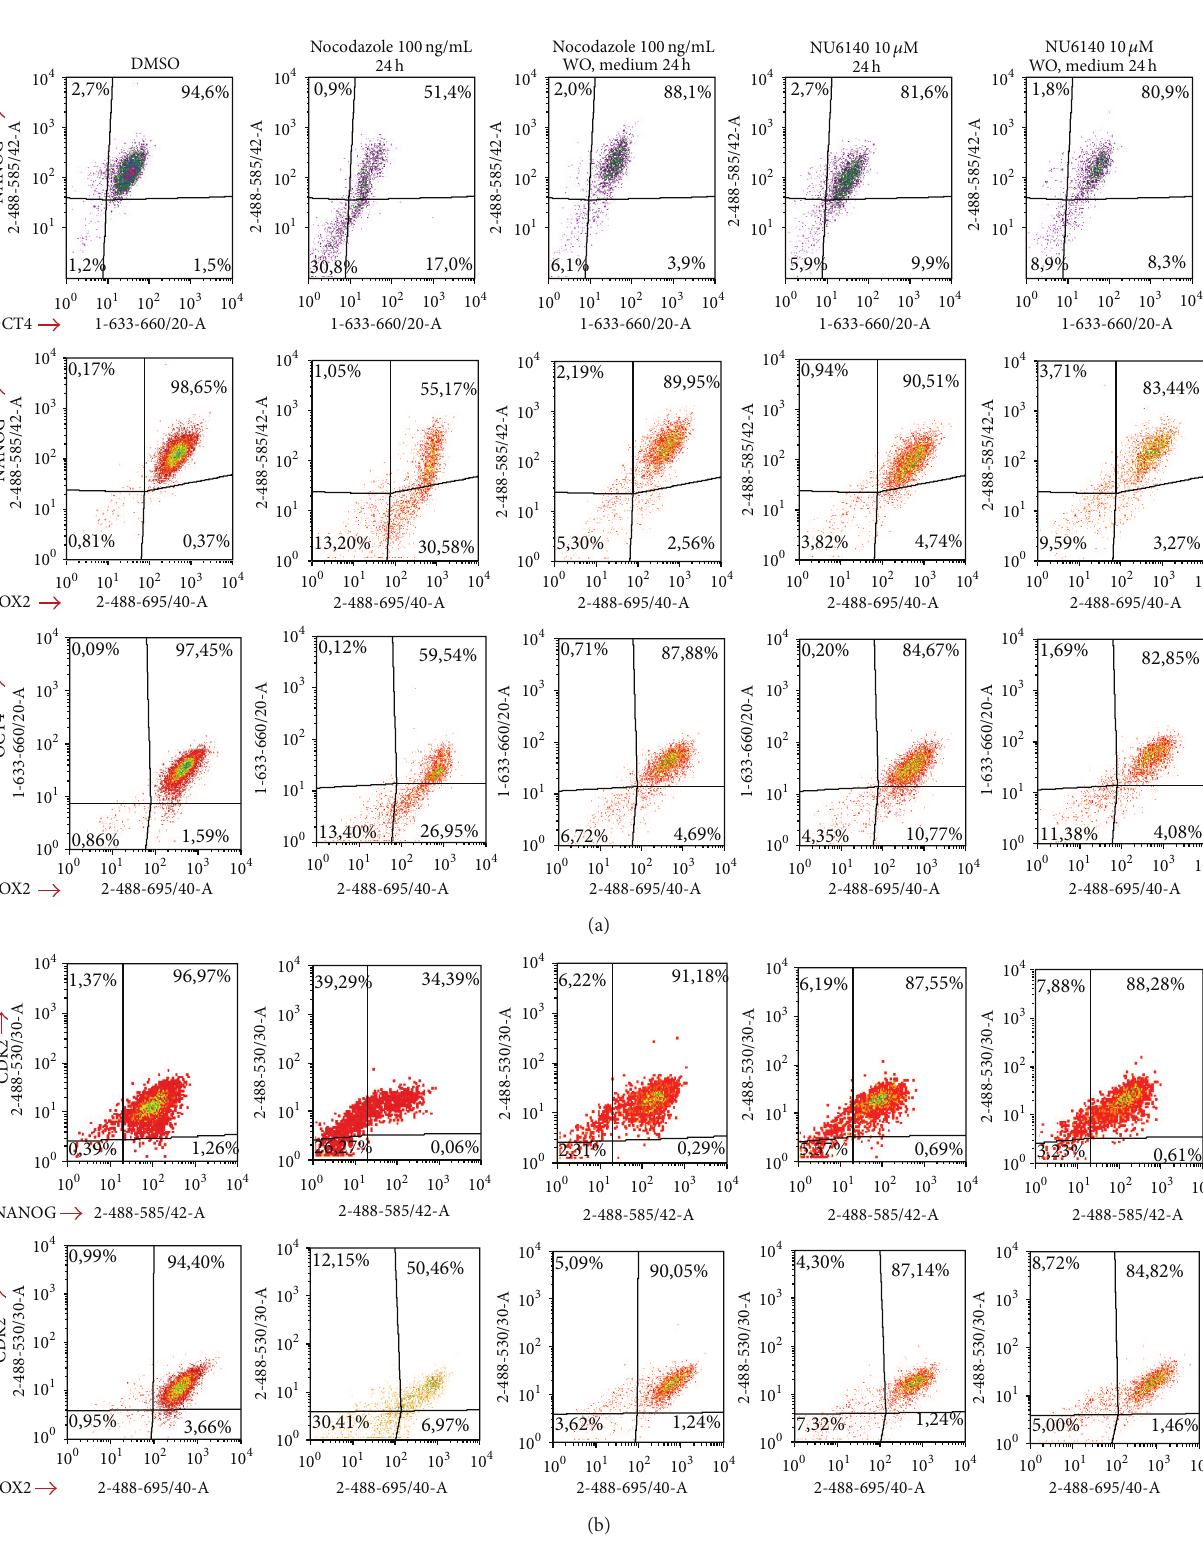
Figure 2: NU6140 treatment compared to nocodazole treatment affects differently the expression of pluripotency markers in 2102Ep carcinoma cells. Expression of pluripotency markers NANOG, OCT4, and SOX2 in nocodazole and NU6140 treated 2102Ep cells as detected by using flow cytometric assays. (a) Fixed and permeabilised (methanol permeabilisation) cells were stained with anti-NANOG (PE), anti- OCT4 (Alexa Fluor 647), and anti-SOX2 (PerCp Cy5.5 conjugate) antibodies and with DAPI. For analysis cellular debris and doublets were excluded. (b) Correlation between expression of CDK2 with NANOG and SOX2. Fixed and permeabilised (methanol permeabilisation) cells were stained with anti-CDK2 (Alexa Fluor 488 conjugate), anti-NANOG (PE), and anti-SOX2 (PerCp Cy5.5 conjugate) antibodies and with DAPI. Results are shown as density